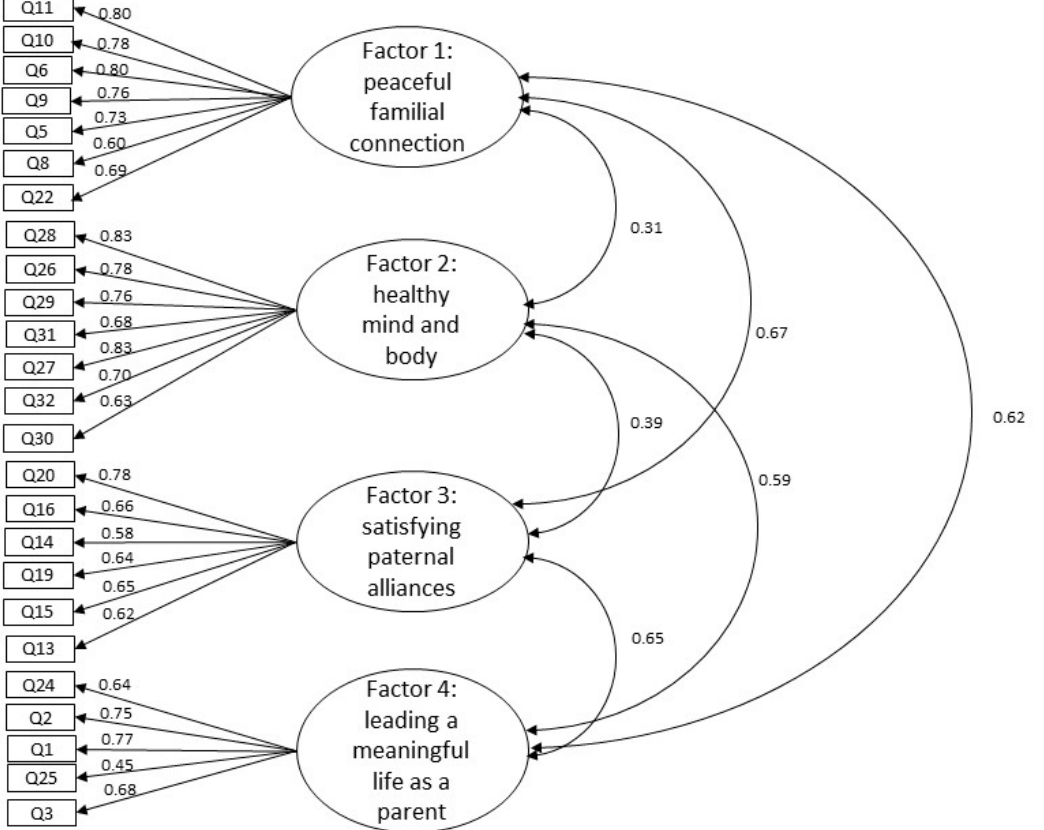
Figure 2. Confirmatory factor analysis of the MSCF based on model A in Table 4. Note: MSCF = Mental Health Scale for Childrearing Fathers. The path coefficient values calculated from the latent variables to the observable variables were statistically significant ( p < 0.001). Correlations between latent variables were also statistically significant ( p < 0.001).